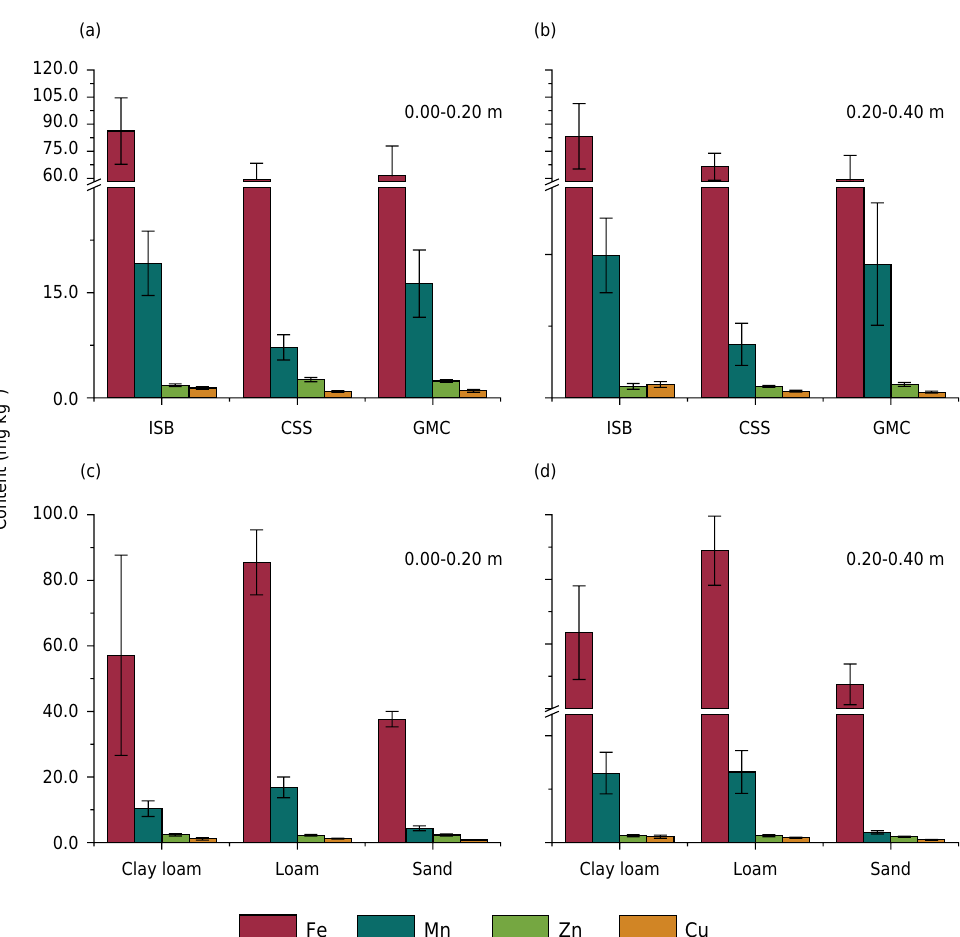
Figure 3. Micronutrient available contents and standard deviation in 0.00-0.20 and 0.20-0.40 m soil layers in different pedogeological contexts (a and b) and with different textural classes (c and d). ISB: igneous-sedimentary basin; CSS: clay-sandy sediments; GMC: gneissic-migmatite